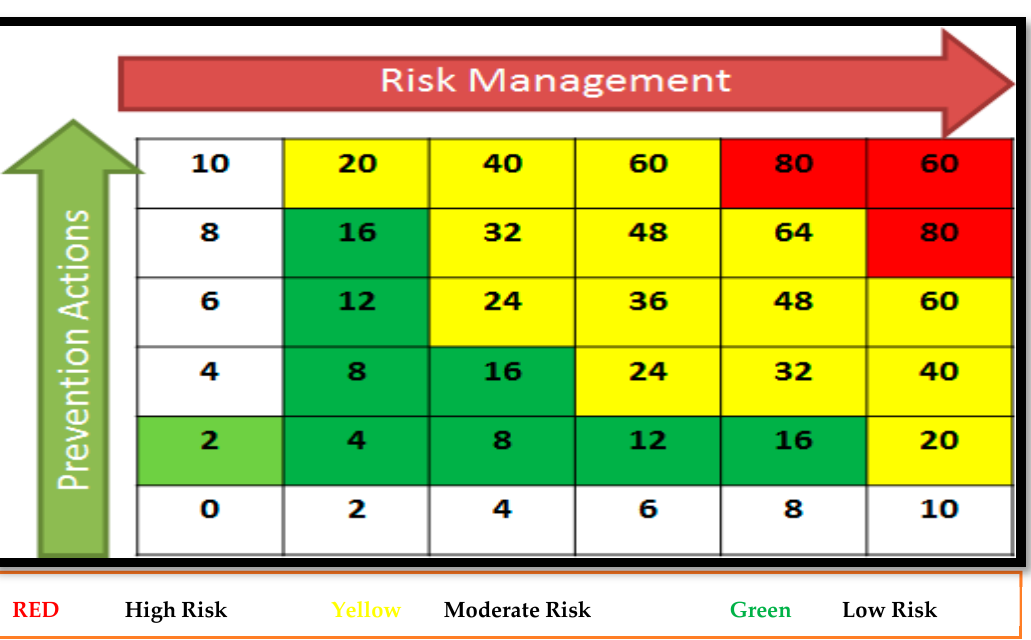
Figure 12. Environmental assessment process stages .